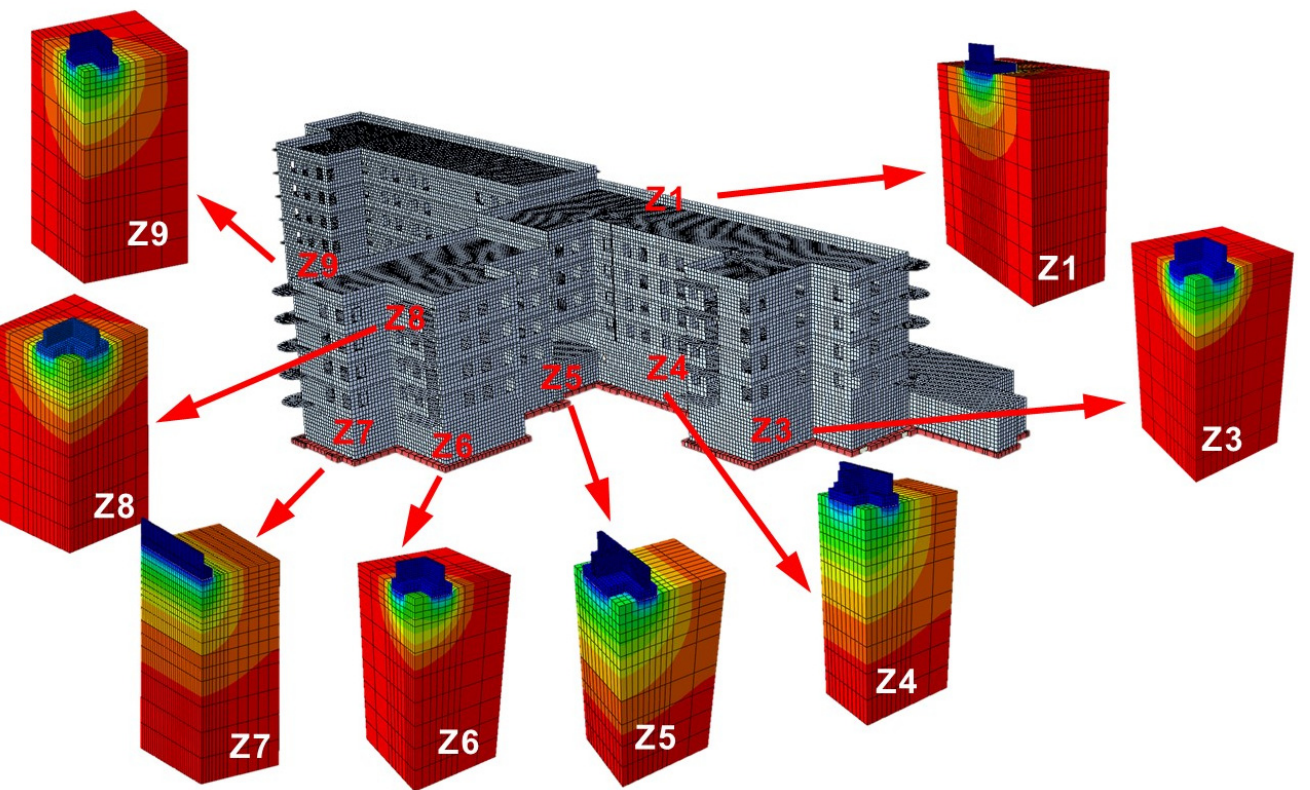
Figure 12. A scheme showing extraction of the partial calibration models.